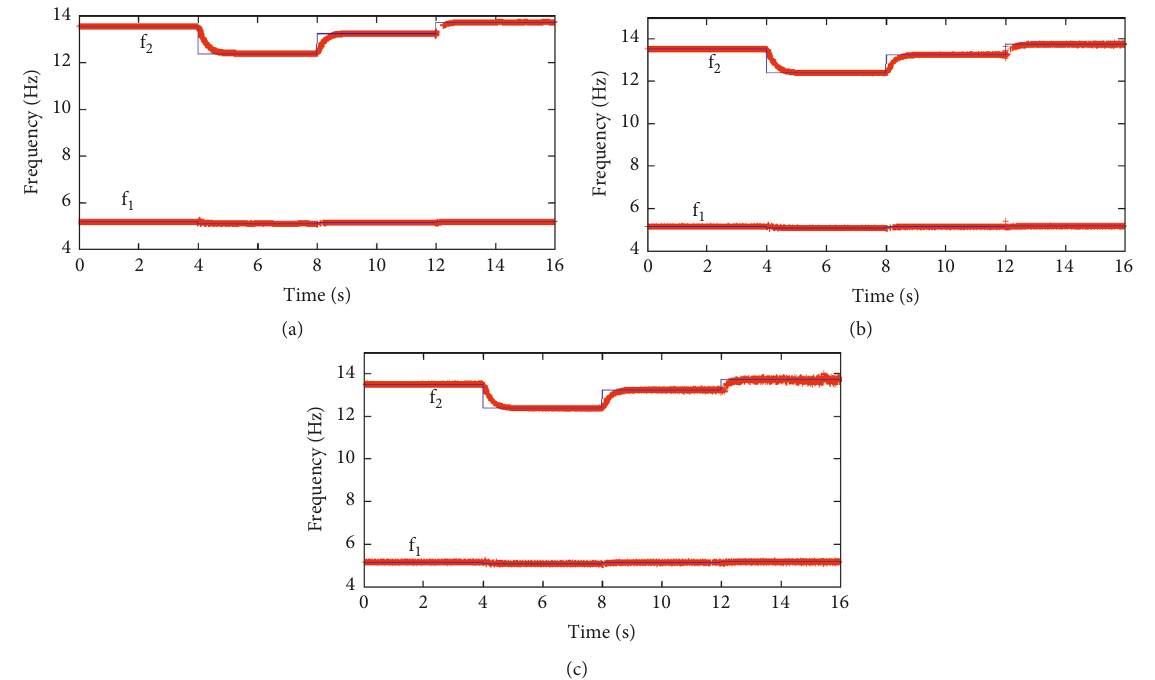
Figure 11: Frequency identification results of the first two modes using vibration signals with different SNR values for simulation case 1 (blue line represents the theoretical value of the frequency, and red line represents the identified value of the frequency): (a) no noise; (b) SNR 50dB; (c) SNR 40dB; (d) SNR 30 (cid:29) (cid:29) (cid:29)